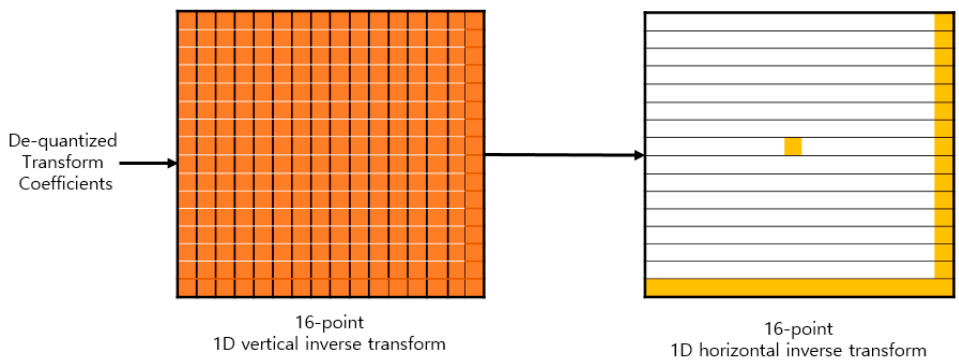
Figure 4. Two-stage partial reconstruction for 16 × 16 inverse